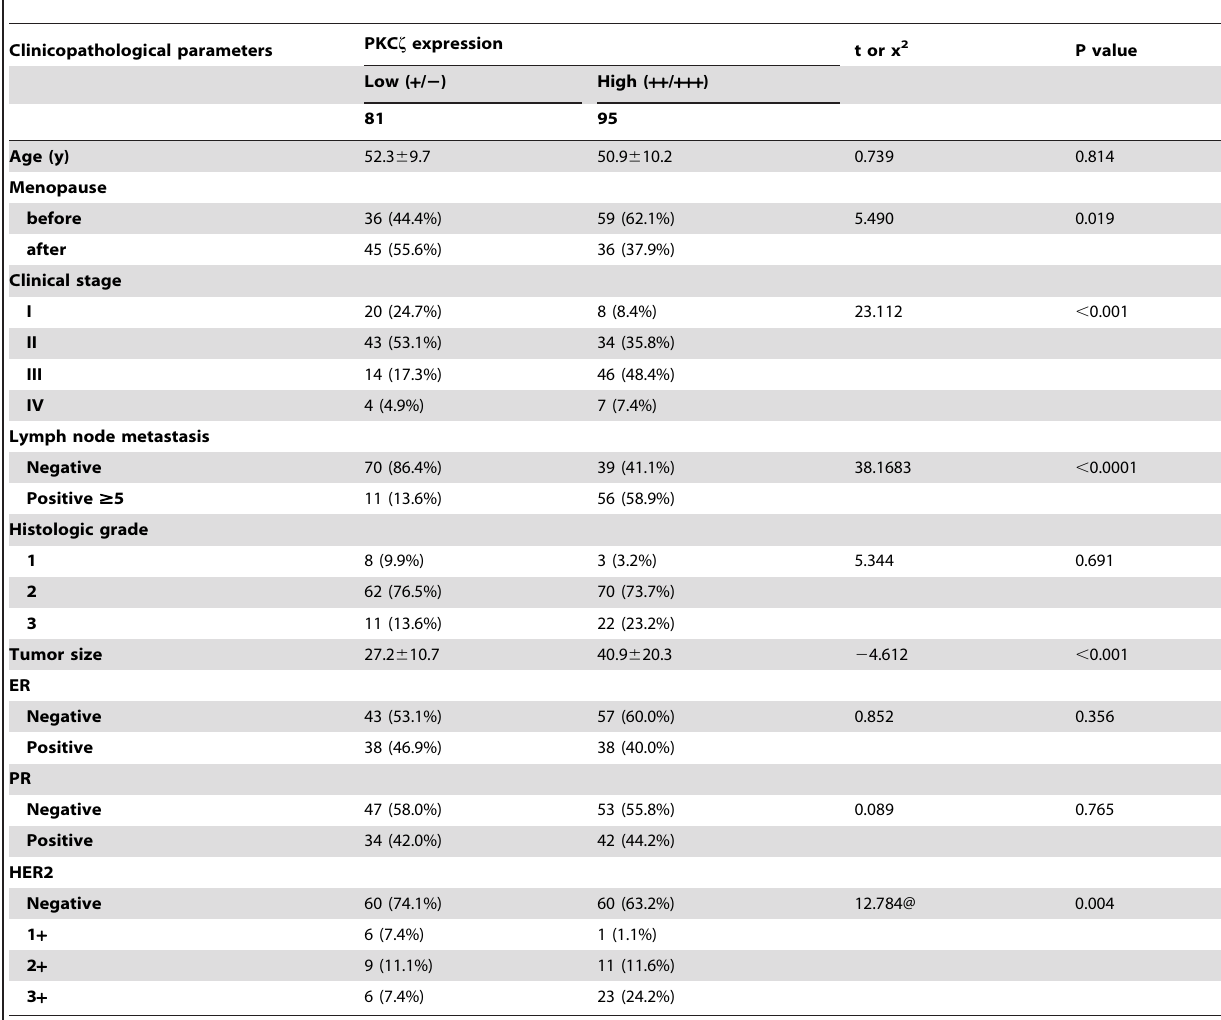
Table 1. Correlation between PKC f expression and clinicopathologic characteristics of human breast carcinomas.